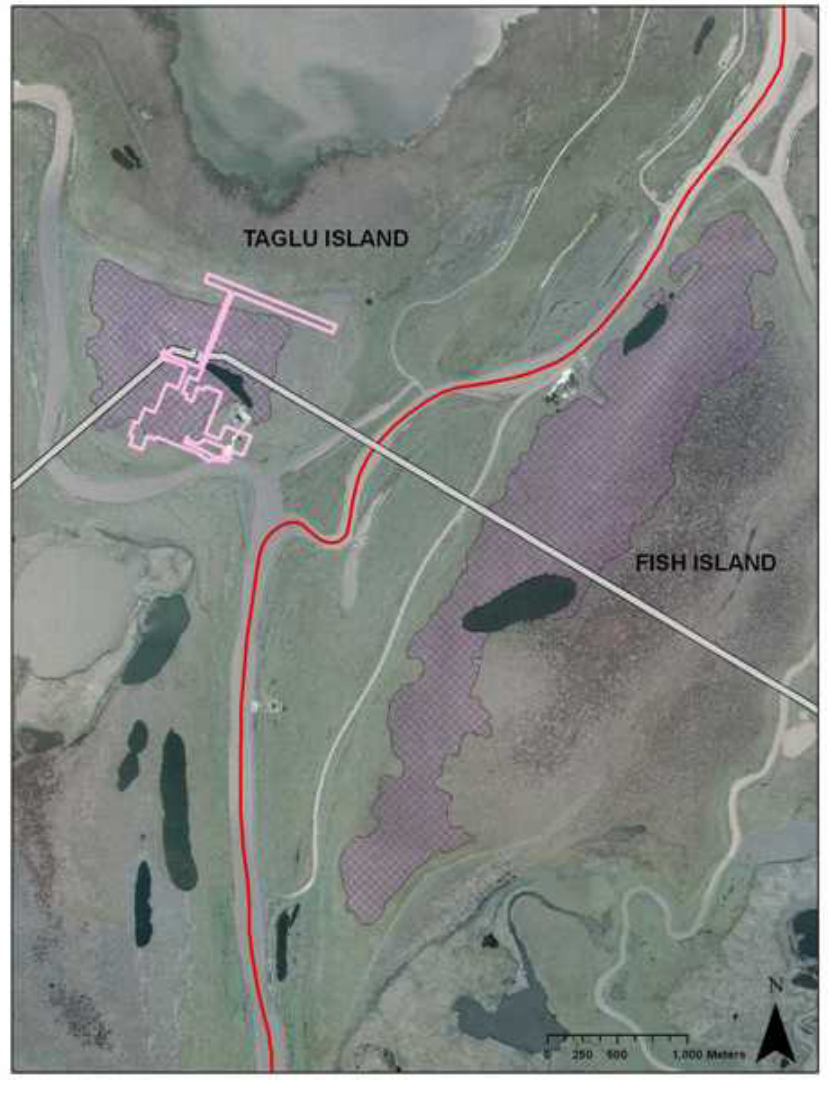
Fig. 3. The proposed Taglu Island gas-processing facility (pink outline) and proposed pipeline (gray line) for the Mackenzie Gas Project, wet-sedge low-centered polygon habitat (purple crosshatch), and the Kendall Island Bird Sanctuary boundary between Taglu and Fish Islands in the outer Mackenzie Delta, Northwest